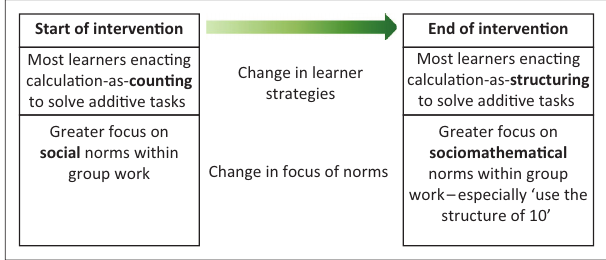
FIGURE 1: A pictorial view of changes in learner strategies and the type of norms in focus across intervention